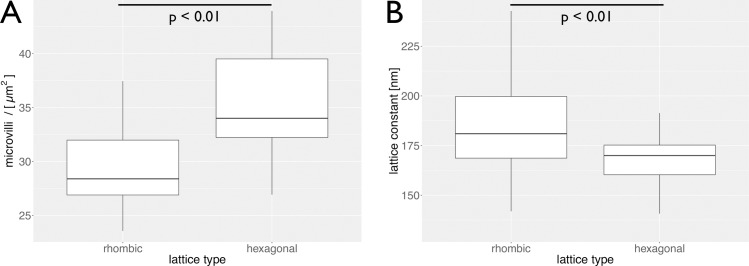
Analysis of different lattice structures of microvilli.(A) Box plot of the median microvillar density for the rhombic and the hexagonal lattice structure. The rectangle represents the 1st and 3rd percentile while the whiskers represent the minimal and maximal measured value. (B) Box plot of the median lattice constant of the rhombic and the hexagonal lattice. The rectangle represents the 1st and 3rd percentile while the whiskers represent the minimal and maximal measured value.